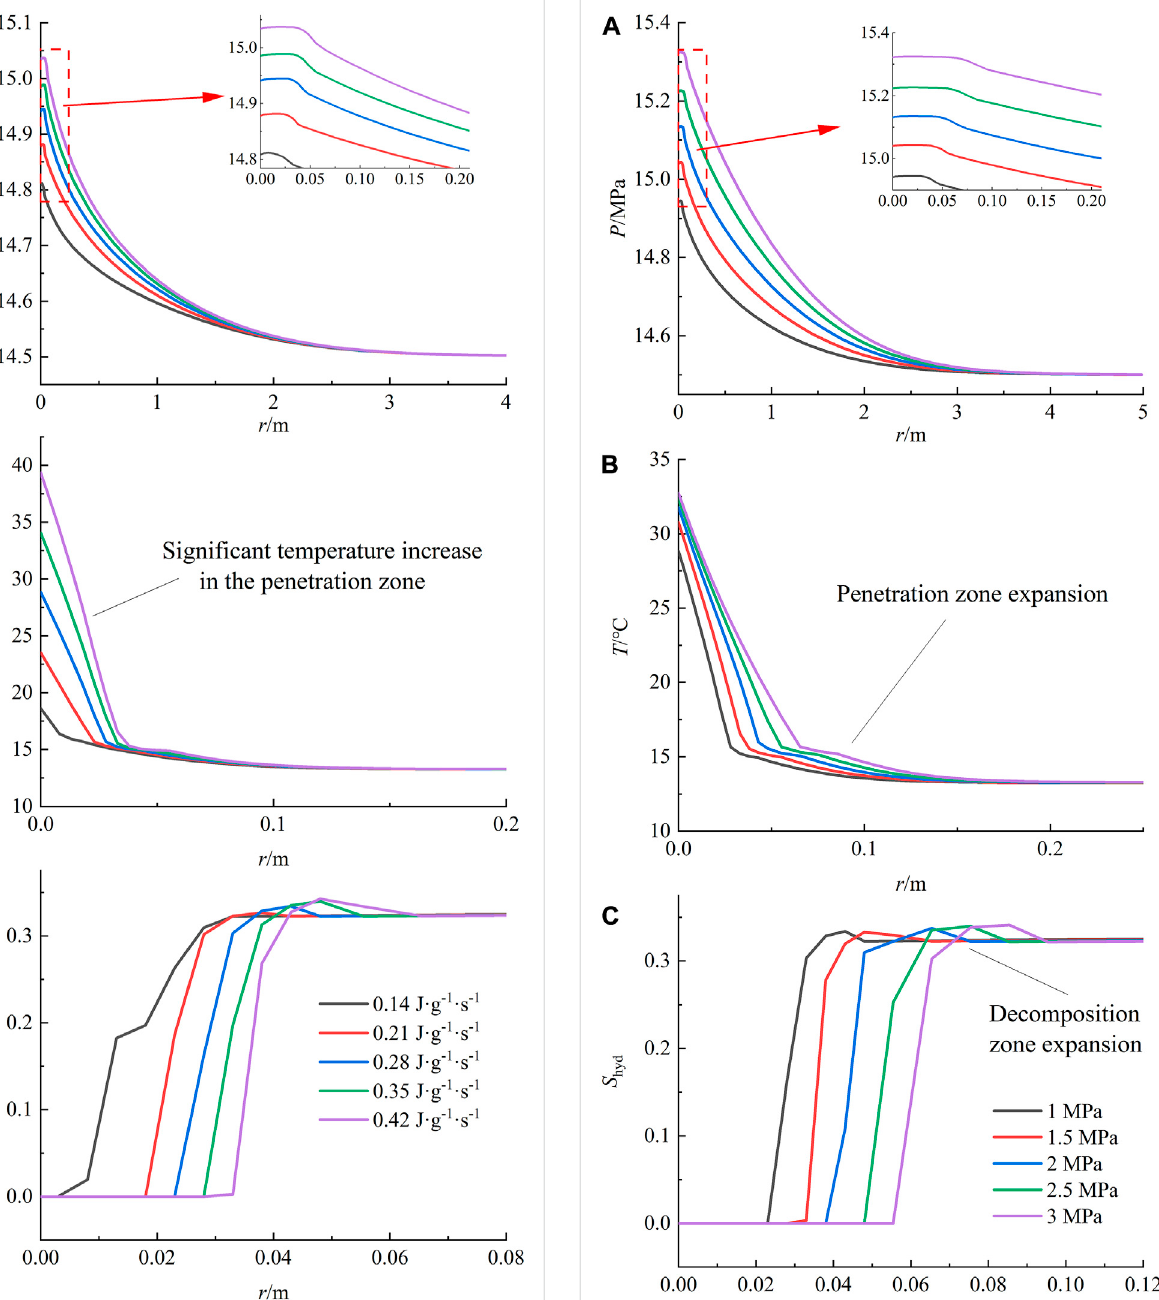
Figures 10B, C show the temperature and hydrate saturation distributions in the late sediments under different HTPDs. As the HTPD increases, the range of the temperature fi eld and hydrate saturation distribution in the sediment does not change signi fi cantly due to the hindering effect of the holding pressure process on hydrate decomposition.